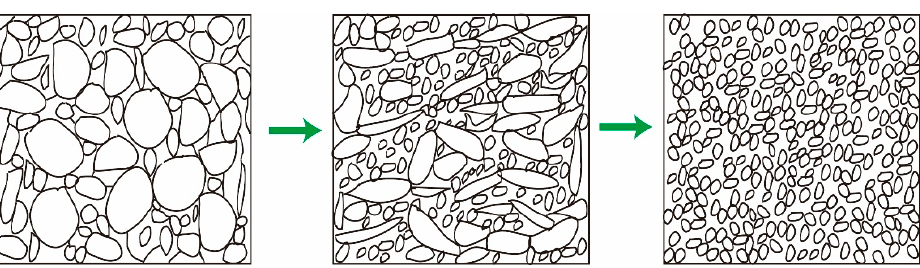
Figure 13. Evolution of dislocation configuration of TC4 alloy after MDIF: ( a ) one cycle; ( b ) four cycles.